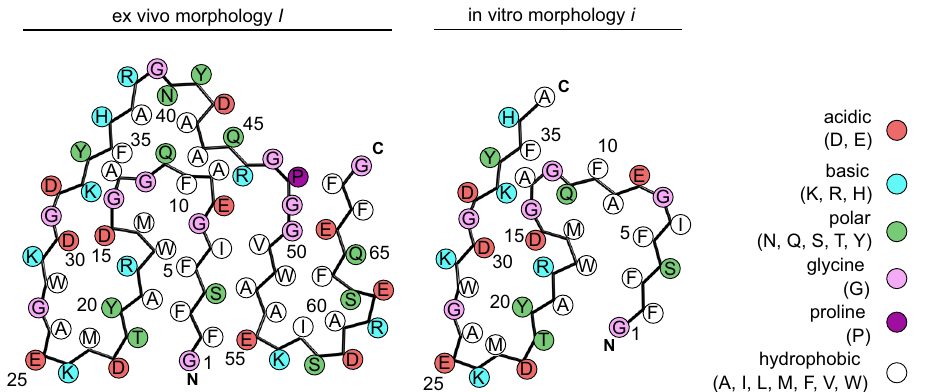
Fig. 4 Schematic view of fi bril protein packing in ex vivo fi bril morphology I and in vitro fi bril morphology i. Comparison of complementary fi bril protein packing in ex vivo fi bril morphology I and in in vitro fi bril morphology i.